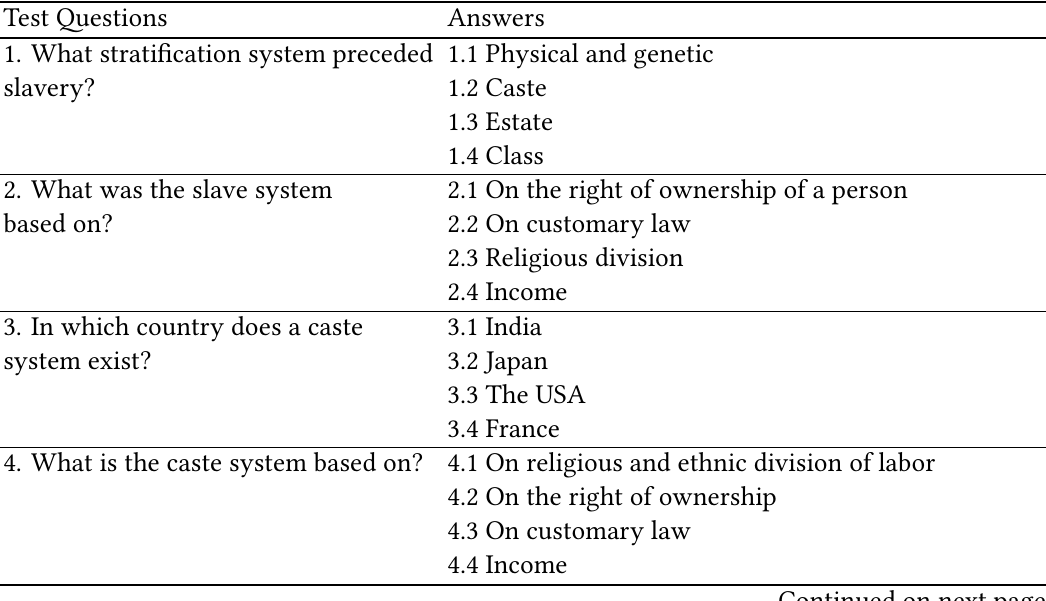
Table 1: Examples of test-quest